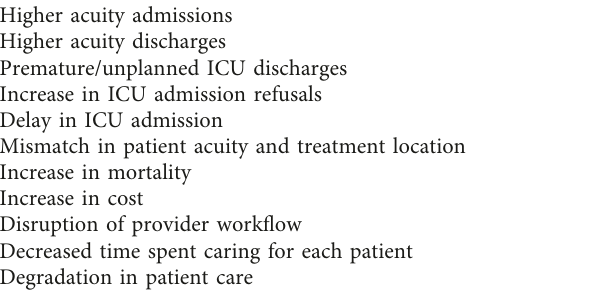
Table 2: Consequences of ICU capacity